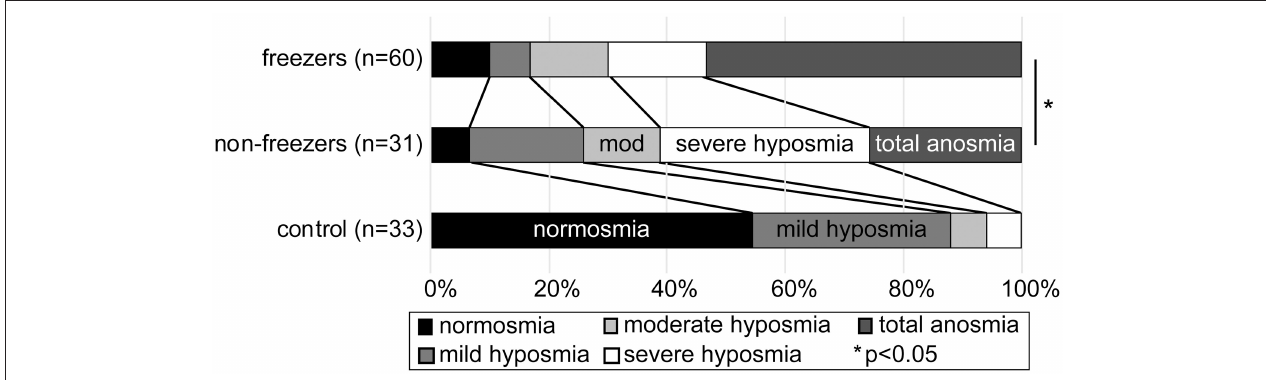
FIGURE 1 | Stacked bar graph showing percentage severity of hyposmia or anosmia in each group, on the University of Pennsylvania Smell Identification test, based on age and sex controlled established normative values. Healthy controls (bottom bar), PD without freezing (middle bar), and PD with freezing (upper bar) are shown. PD freezers were significantly more likely to have an anosmic phenotype than